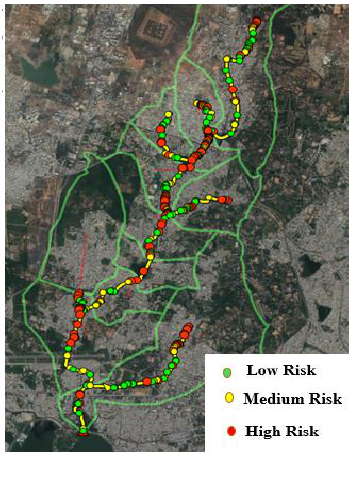
Figure 9: Risk map for junctions Table 5: Classification of node under different risk